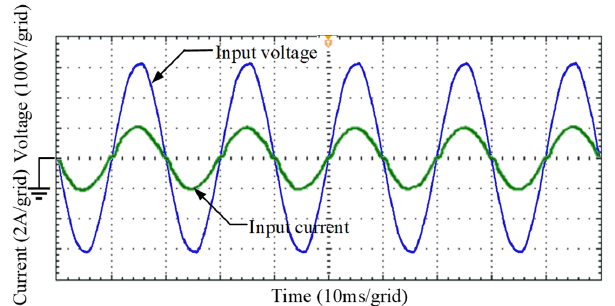
Figure 30. Input current and voltage